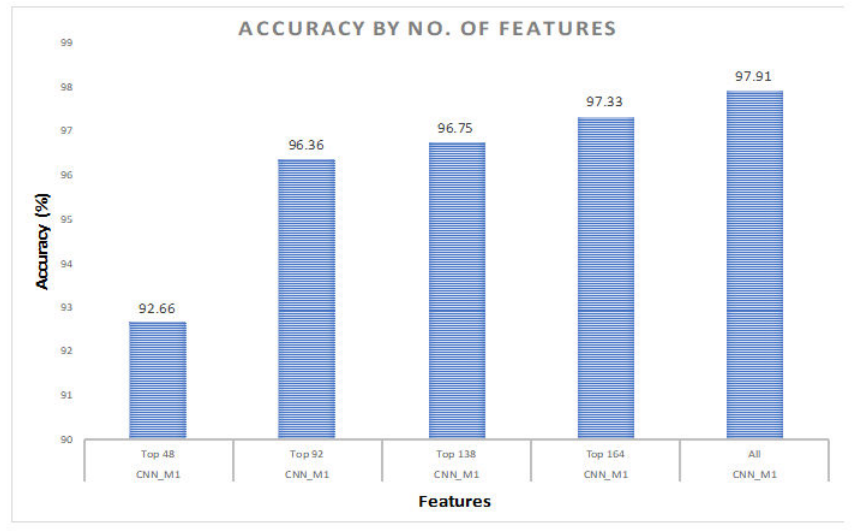
Figure 11. Accuracy by number of features for